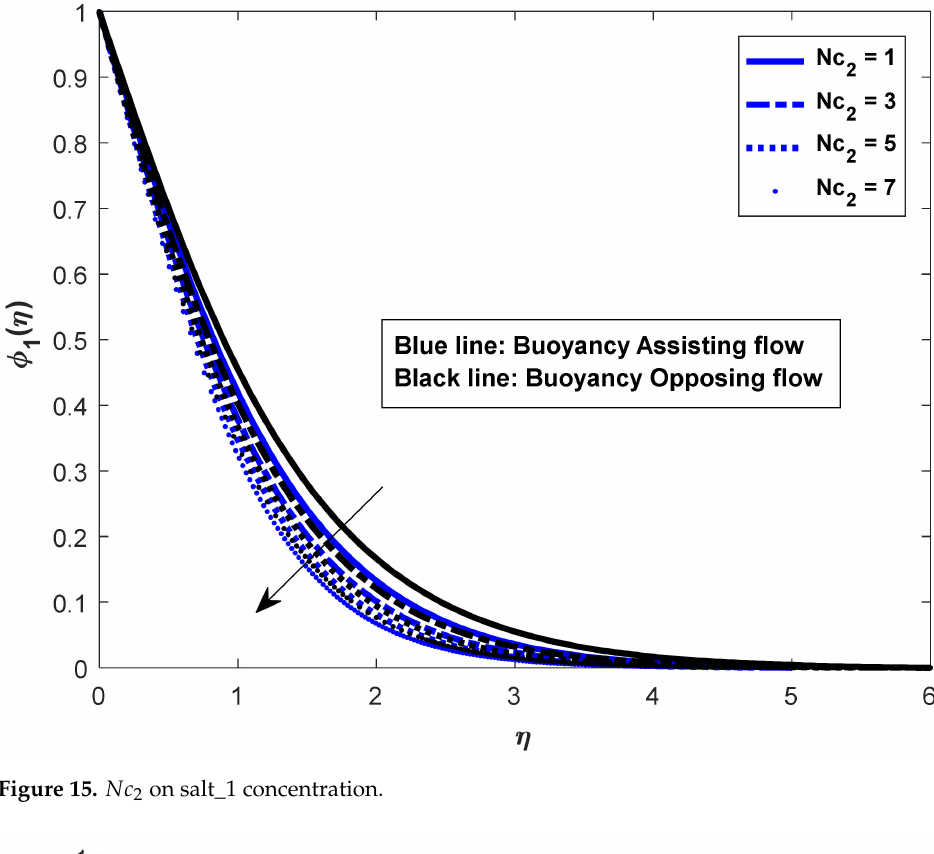
Figure 15. Nc 2 on salt_1 concentration.